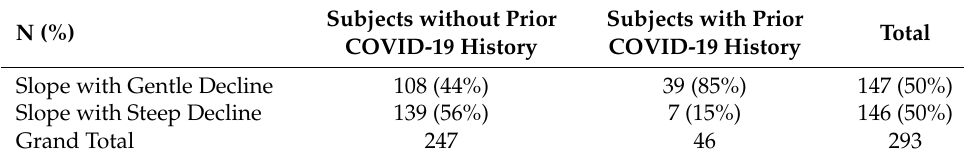
Figure 2. Antibody Decay Slope per baseline COVID infection history. Slopes in antibody levels from Month 2 through Month 9 were compared between subjects with COVID-19 history before vaccination (n = 46), and without COVID-19 history prior to vaccination (n = 249). The slope of an- tibody decline over time was significantly steeper in the subjects without a history of pre-vaccina- tion COVID-19 infection. *** p < 0.001 .